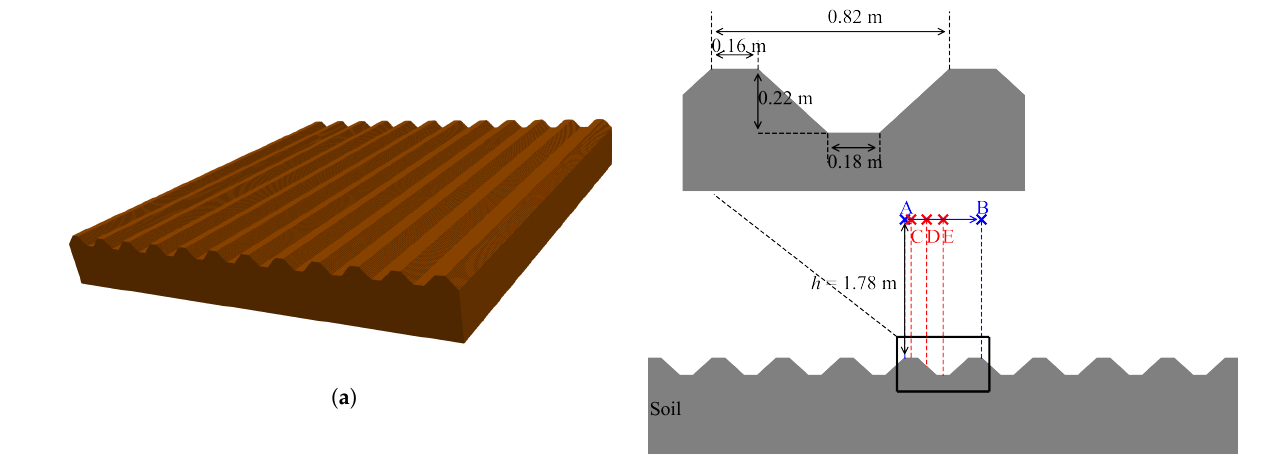
Figure 1. Potato trench-hill soil simulation model in gprMax. ( a ) the 3D model and ( b ) the 2D slice and configurations. Configuration i, the source/receiver moved and measured from point A to B with a step of 0.02 m, resulting in 50 measurements for each centre frequency (150 MHz, 250 MHz and 450 MHz). The soil relative permittivity stays the same, i.e., ε r = 10. For configuration ii, the 150 MHz centre frequency source/receiver is situated above the centre of the top (point C), slope (point D) and bottom (point E) of the trench-hill surface, respectively, and ε r varies from 5 to 22 with a step of 1. h is the distance between the source/receiver and the top of the surface. All measurements were conducted with the source/receiver at the same height, i.e., h = 1.78 m when the source/receiver above the top and h = 2 m when above the